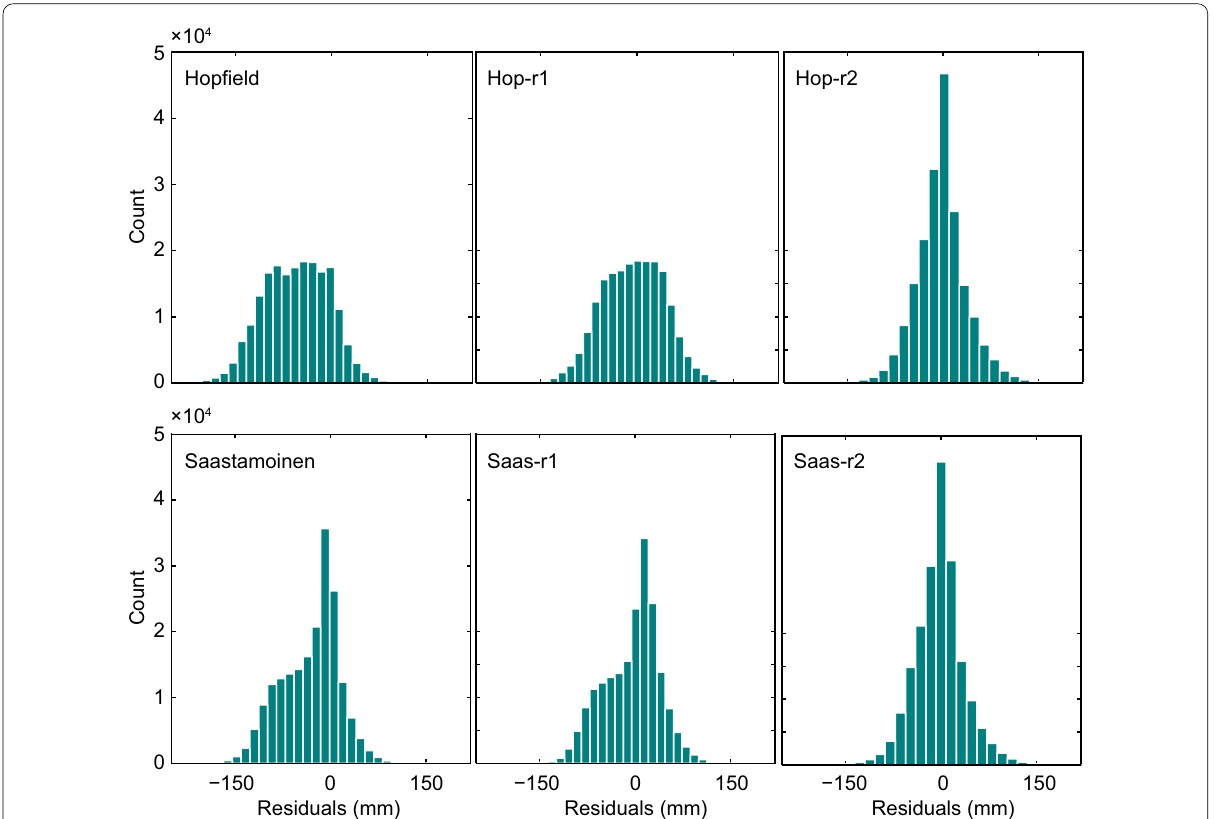
Fig. 9 Histogram of the residuals between the ZTD derived from six models and the referenced